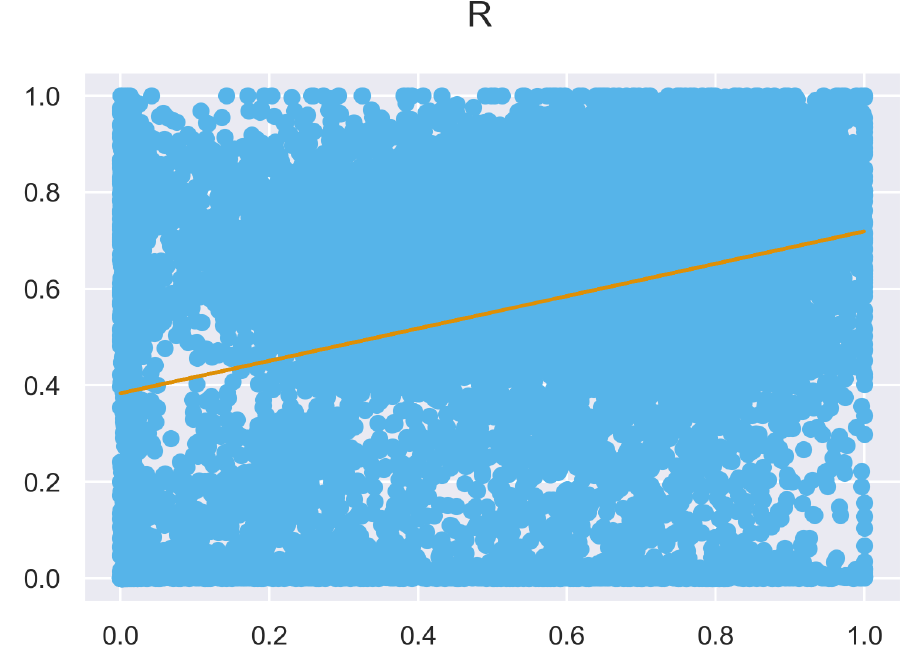
Figure A13. ULS and TLS R regression at 0.5 m grid size.